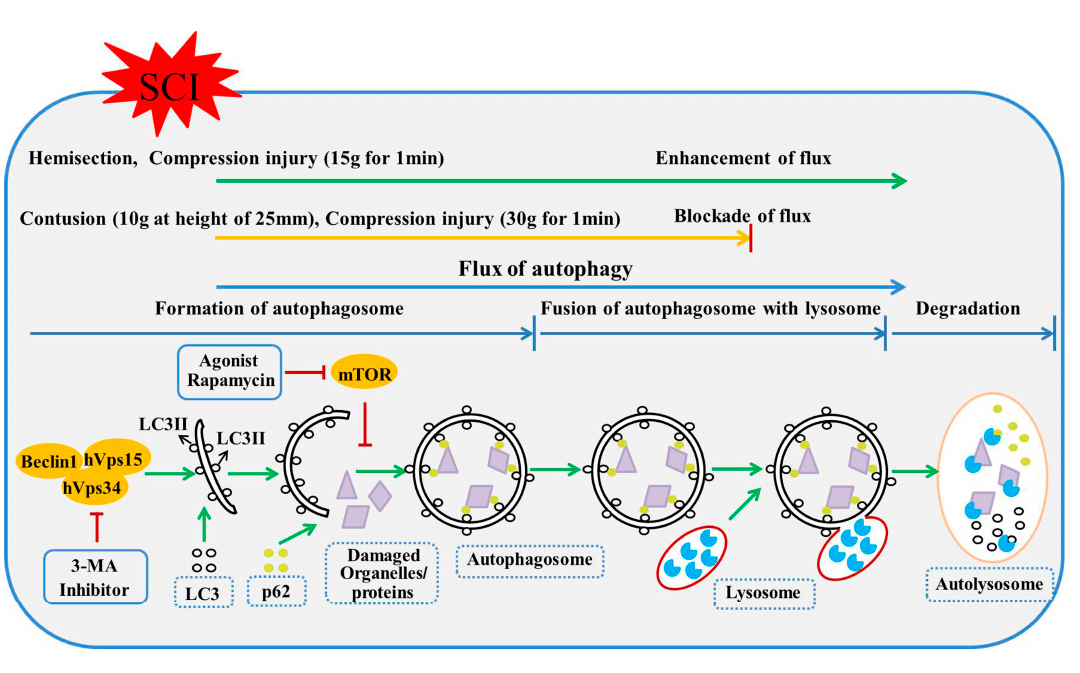
Figure 2. The autophagic process includes three steps: formation of autophagosomes, fusion of autophagosomes with lysosomes, and degradation in the autolysosome. Flux of autophagy is used to describe the whole dynamic process of autophagy, and is discrepant in different traumatic spinal cord injury (TSCI) types. The flux is enhanced in hemisection injury [27] and moderate compression injury (15 g for 1 min) [26], whereas it is blocked in severe contusion injury (10 g at height of 25 mm) [32] and compression injury (30 g for 1 min) [38]. Autophagic agonists (rapamycin) and inhibitors (3-methyladenine, 3-MA) targeting the process of autophagy are presented. The green arrows stands for progressing autophagy process and red T-bars stands for blocking of autophagy process. LC3: microtubule-associated 1 protein light chain 3; mTOR: mammalian target of rapamycin.